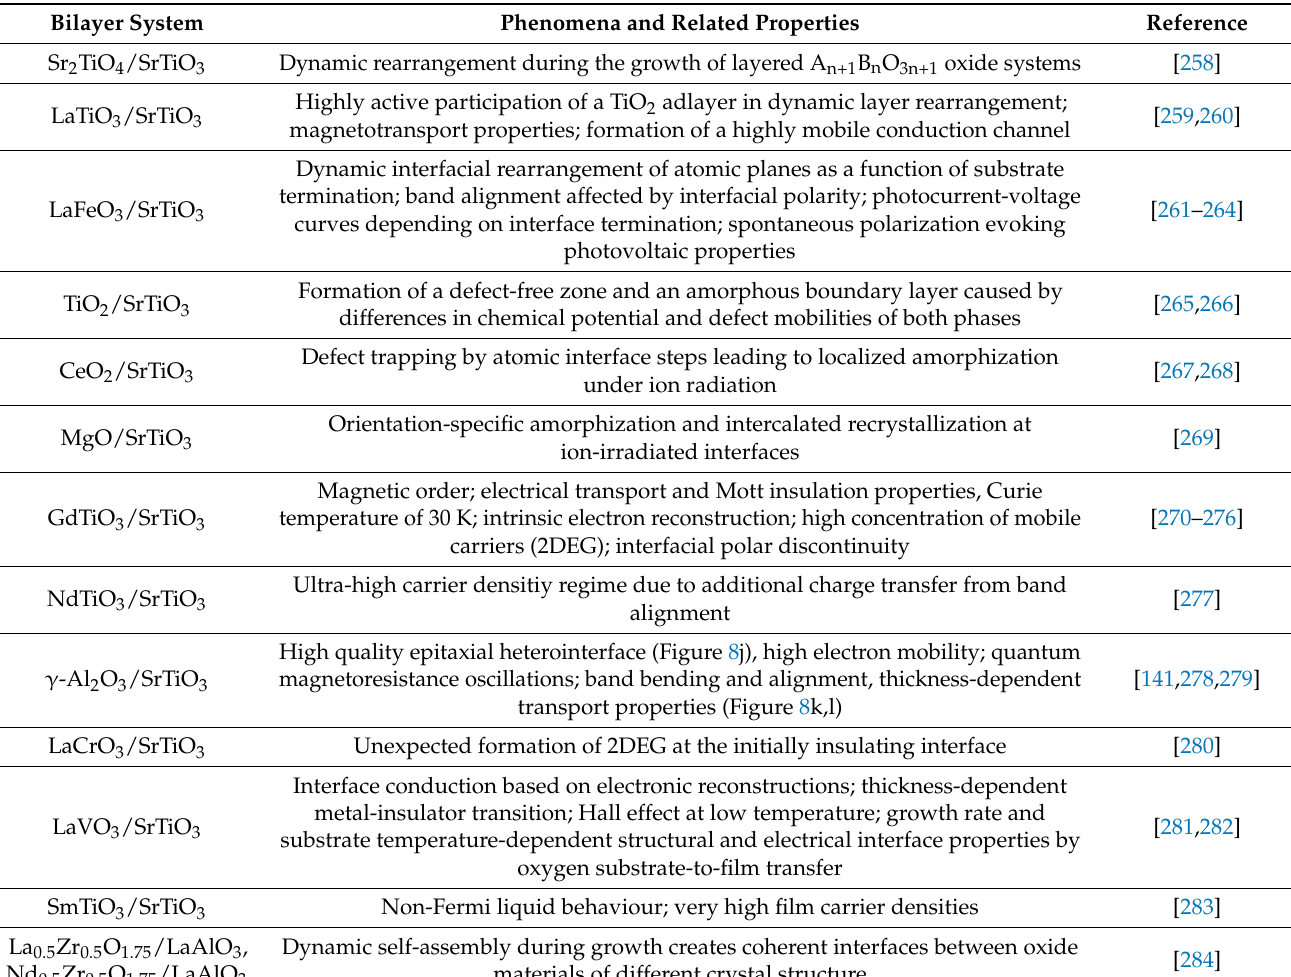
Table 1. Property phenomena in bilayered